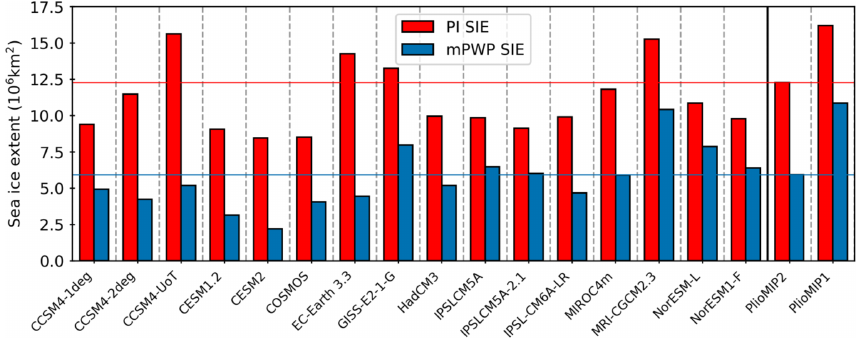
Figure 4. Mean annual SIE (10 6 km 2 ) for the pre-industrial and mPWP simulations. The horizontal lines represent PlioMIP2 MMM